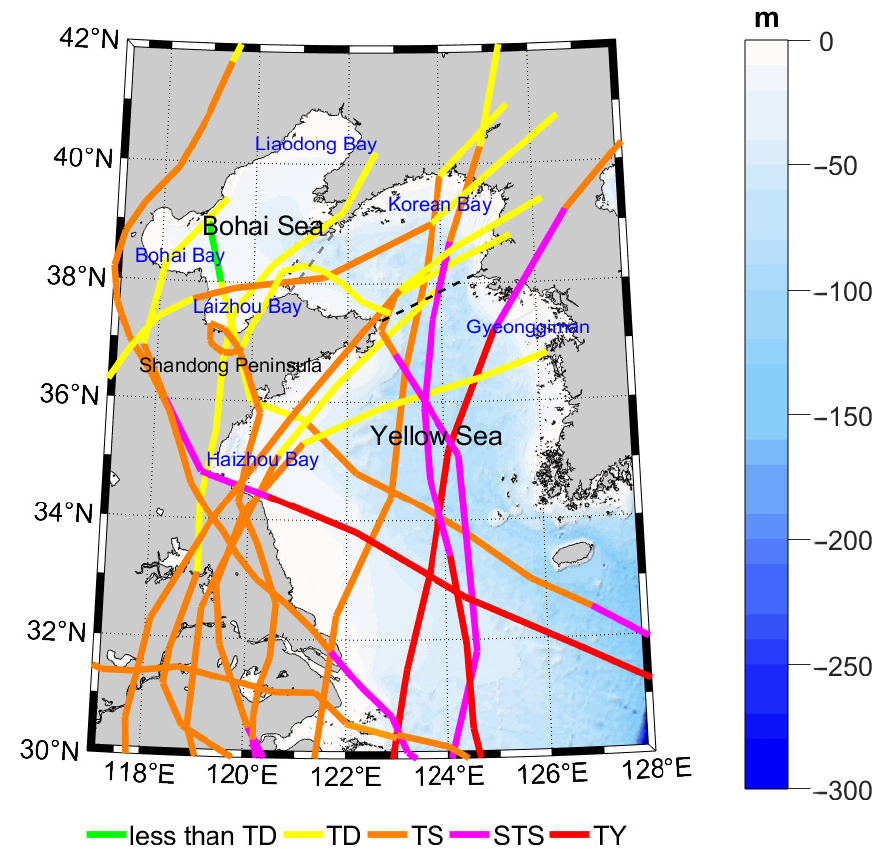
Figure 1. Historical paths of typhoons that have passed through the Northern East China Sea from 2000 to 2019. Different colors represent different typhoon intensities, which were classified by the China Meteorological Administration, including TD (Tropical Depression), TS (Tropical Storm), STS (Strong Tropical Storm), and TY (Typhoon). Bathymetry is shown in blue in the background. The gray dash line is the dividing line between the Bohai Sea and the Yellow Sea. The black dash line is dividing line between the Northern East China Sea and the South Yellow Sea. Data of typhoon intensities are from CMA Tropical Cyclone Data Center [32] .